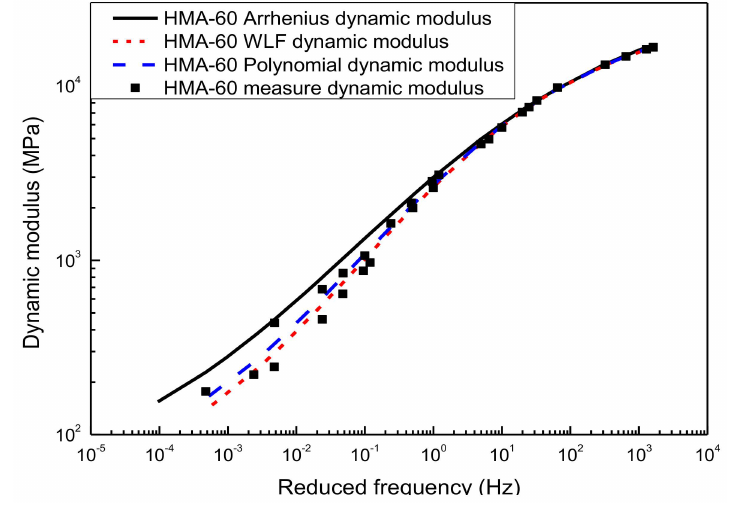
Figure 8. Generalized sigmoidal dynamic modulus master curve of HMA-60.